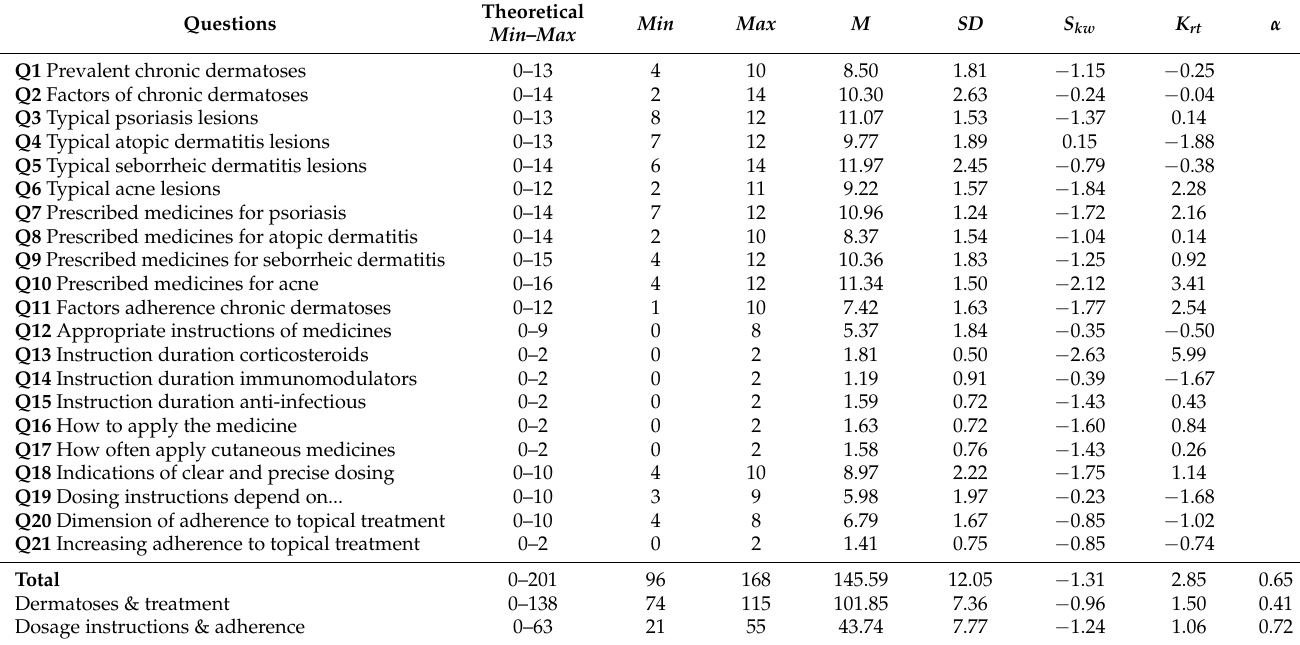
Table 1. Pharmacists’ answers, total and subscales description ( N =